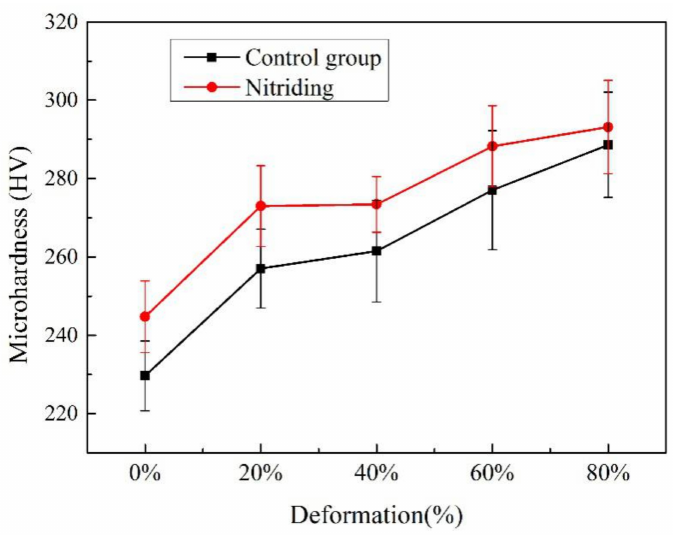
Figure 12. Microhardness values of cold-rolled deformed alloy samples before and after